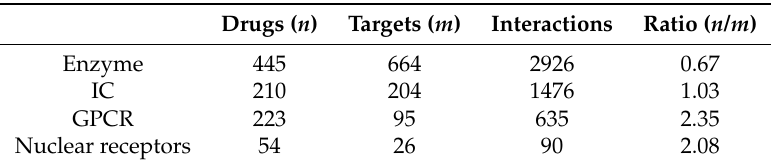
Table 1. Statistics of DTI datasets